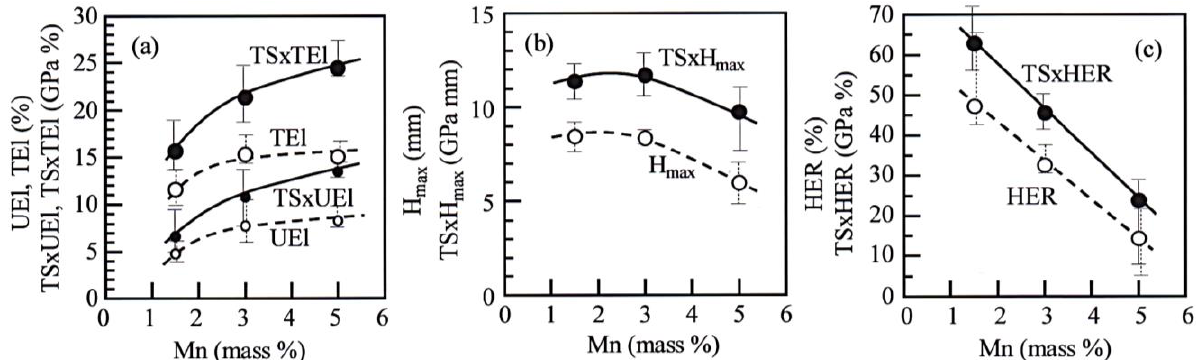
Figure 7. Mn content dependences of ( a ) UEl, TS × UEl, TEl, and TS × TEl and ( b ) H max and TS × H max , and ( c ) HER and TS × HER which are averaged values of the steels subjected to the IT process at temperatures between M s and M f − 100 ◦ C (corresponding to dotted frames in Table 2).